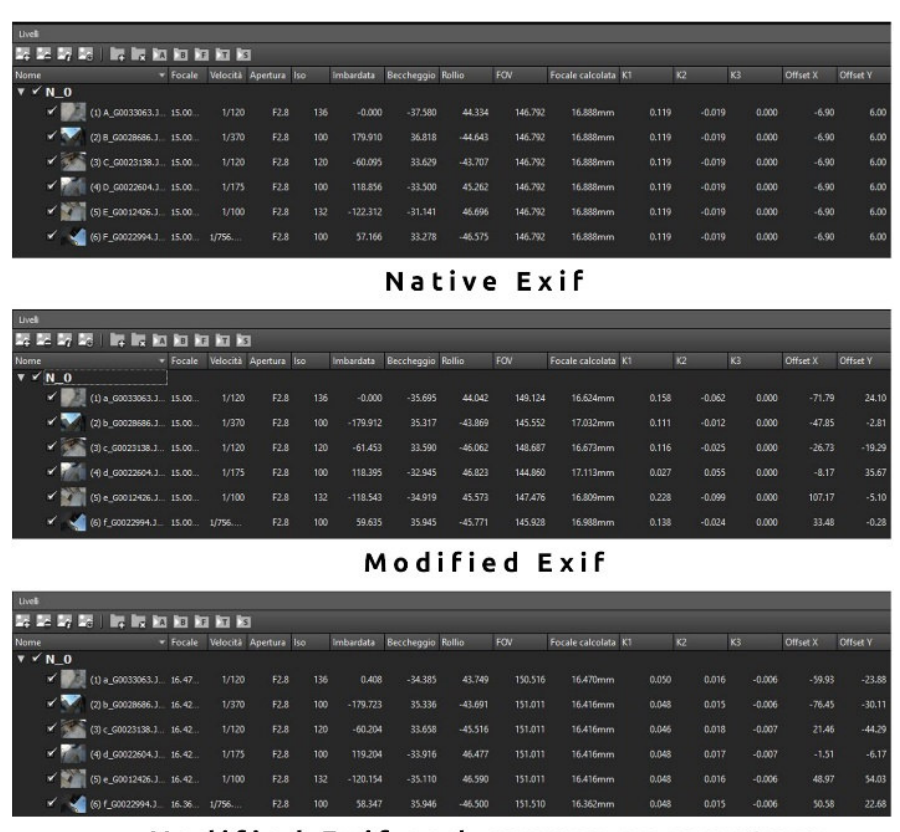
Figure 13. Camera parameters used in three different approach in AutoPano Giga.